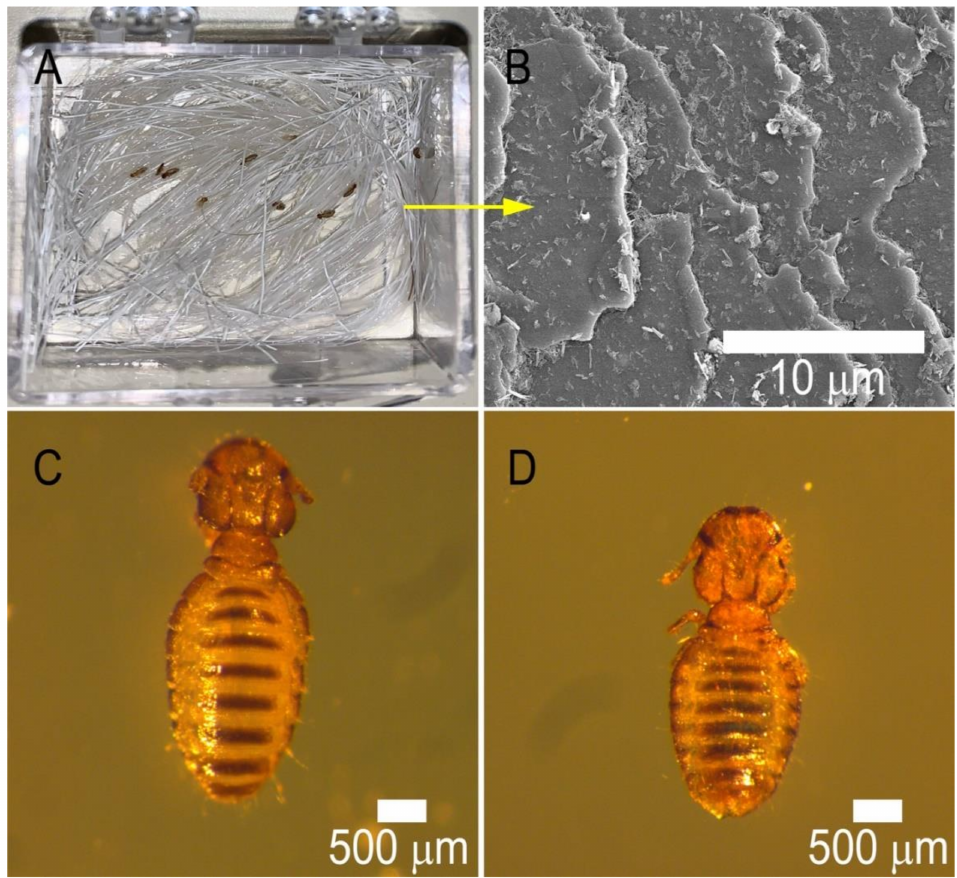
Figure 9. A photograph demonstrating the experimental setup and live lice crawling on halloysite-permethrin coated hair strands within the special humidity cell (glass box dimension 1 inch × 1 inch) ( A ) and SEM images of the same hair strand ( B ). Optical microscopy image of a young adult live louse ( C ) and a dead louse ( D ) with a noticeable curled body and shrunken abdomen. Table 4. Mortality of permethrin solution on the application on D. caprae lice after multiple hair washing. Number of Lice Survived/Recorded Time (h) Experimental Formulation. 0 4 8 16 24 Hair treated with 0.5% permethrin 10 1 ± 1 0 0 0 Hair washed one time after 0.5% 10 5 ± 1 2 ± 1 0 0 permethrin treatment Hair washed two times after 0.5% 10 8 6 ± 1 6 ± 1 6 ± permethrin treatment